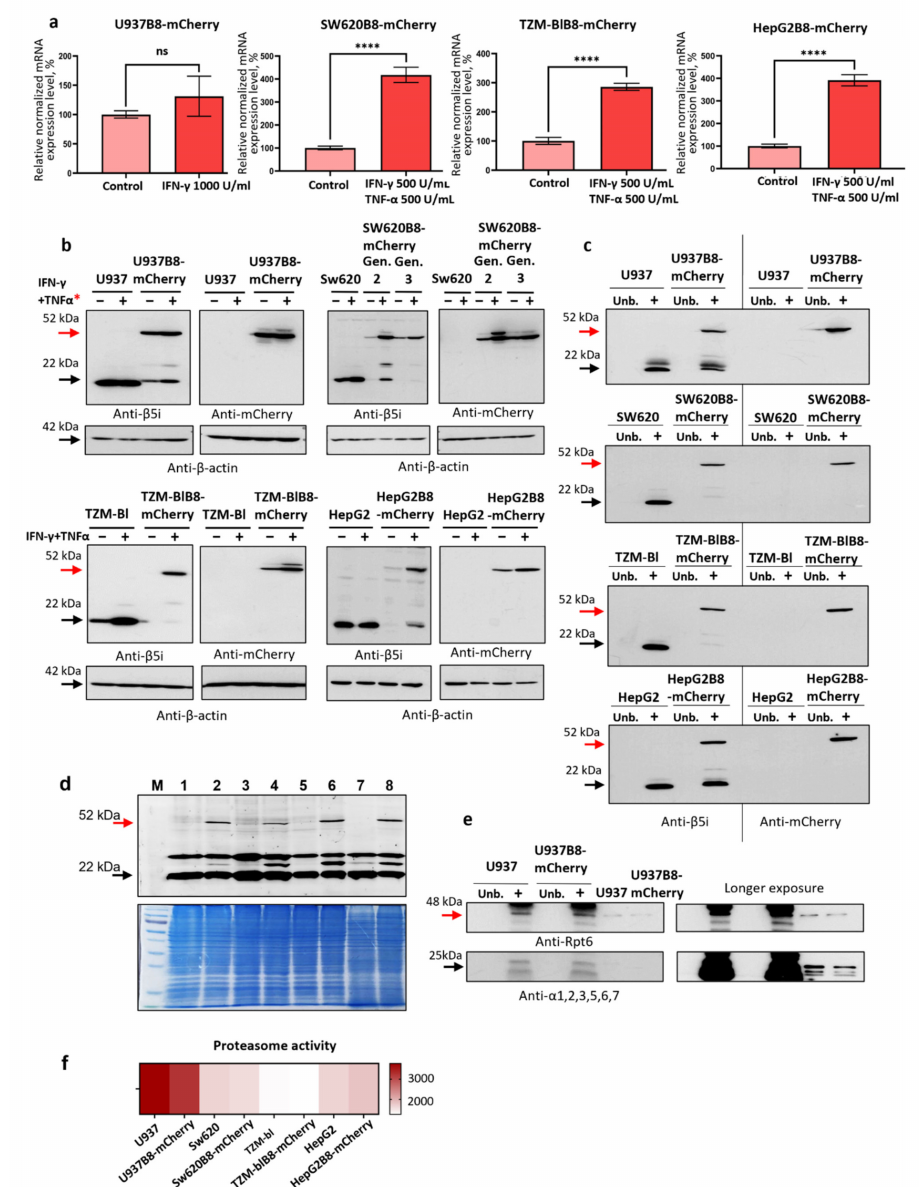
Figure 2. The β 5i-mCherry chimera is integrated into the proteasome and is an active proteasome subunit in edited cells. ( a ) The relative expression levels of PSMB8-mCherry RNA in unstimulated U937B8-mCherry, SW620B8-mCherry, TZM-blB8mCherry and HepG2B8mCherry cells and cells treated with IFN- γ (1000 U/mL) and TNF- α (500 U/mL) for 48